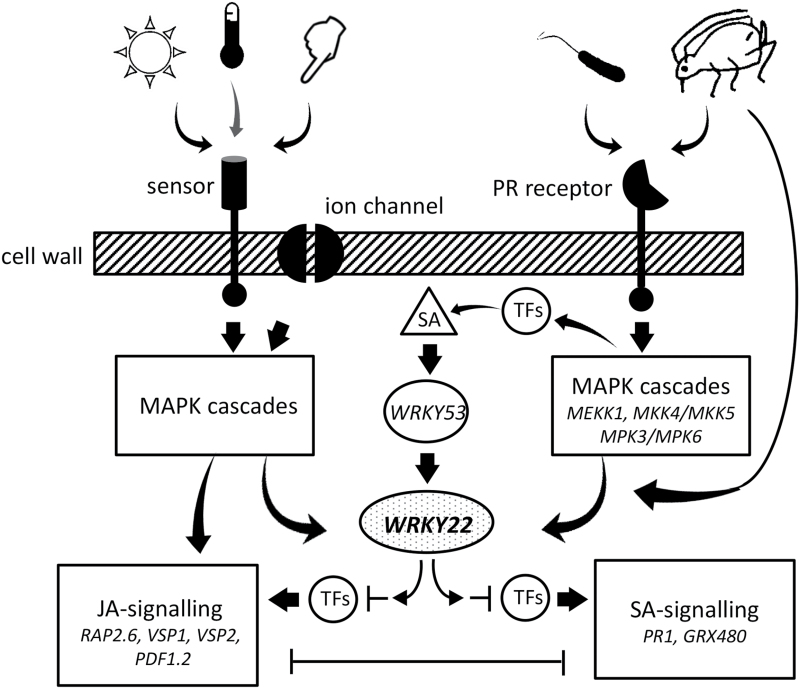
Hypothetical model of WRKY22’s role in plant response to abiotic (left) and biotic (right) stresses. Changes in, for example, light, temperature and touch are perceived via sensors and ion channels; plant invasion by organisms such as bacteria and aphids is mainly perceived via pattern-recognition (PR) receptors. These stimuli induce WRKY22 directly via MAPK cascades (Ichimura et al., 2000; Asai et al., 2002), or indirectly via SA accumulation (Miao et al., 2004; Miao and Zentgraf, 2007). Alternatively, aphid effectors secreted via the saliva may induce WRKY22 via PR-receptor-independent routes. WRKY22 subsequently integrates signalling of the JA and SA pathway, by inhibiting or activating specific transcription factors (TFs) and other regulatory genes.